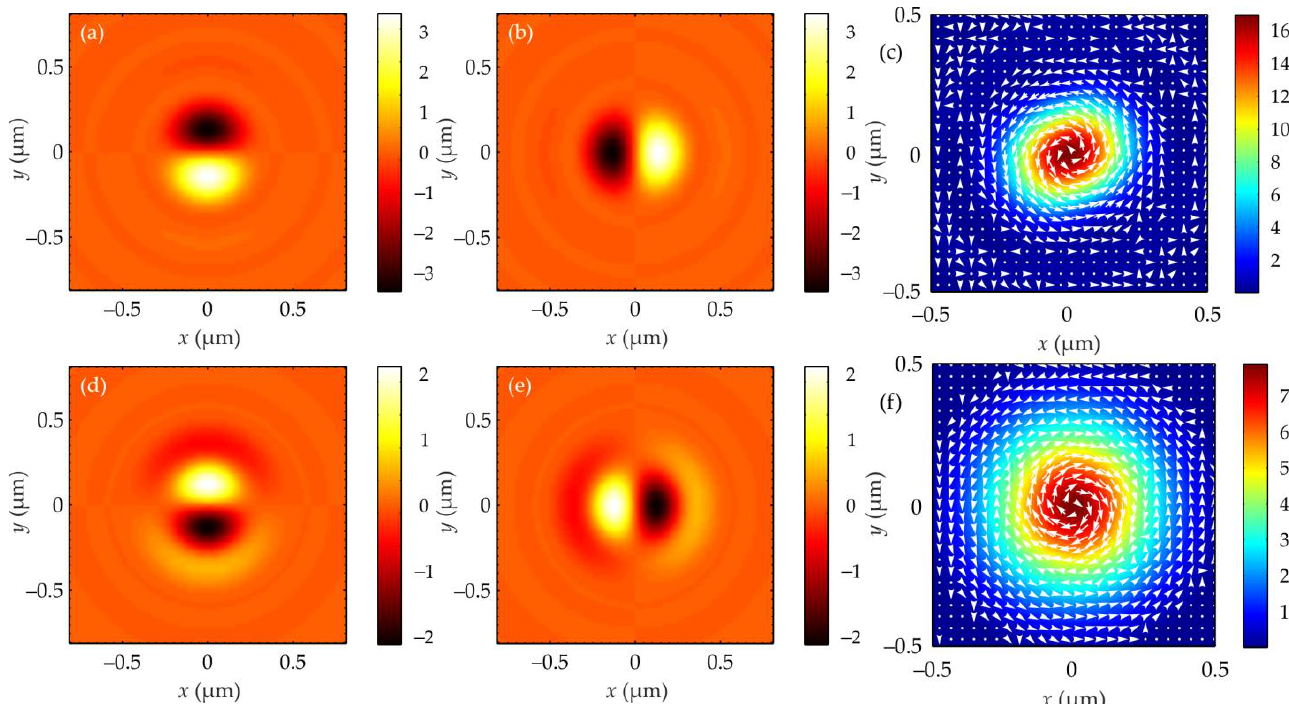
7 of 11 Figure 1. Intensity patterns at the focus for different Poincaré beams of Equation (1): θ = π /4, ψ = π /4, n = 0 ( a ); θ = 0, ψ = π /2, n = 0 ( b ); θ = π /4, ψ = π /4, n = 1 ( c ); θ = 0, ψ = 0, n = − 1 ( d ). From Figure 1, beams with elliptical (a), circular (b), and near-radial (c) polarization are seen to produce an elliptic or circular focal spot, whereas a vortex beam with circular polarization (d) produces an annular focal spot. Such types of intensity patterns agree well with Equation (8). Figure 2 depicts transverse Poynting vector components P x (a,d) and P y (b,e) at the foci of two out of the four beams shown in Figure 1. The energy flow in Figure 1a for the beam with the parameters θ = π/4, ψ = π/4, n = 0 is identical to those for the beams with θ